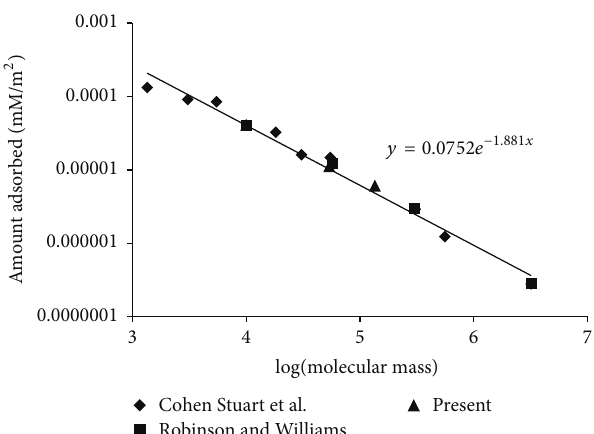
Figure 8: The amount of polymer adsorbed as a function of molec- ular mass of polymer.